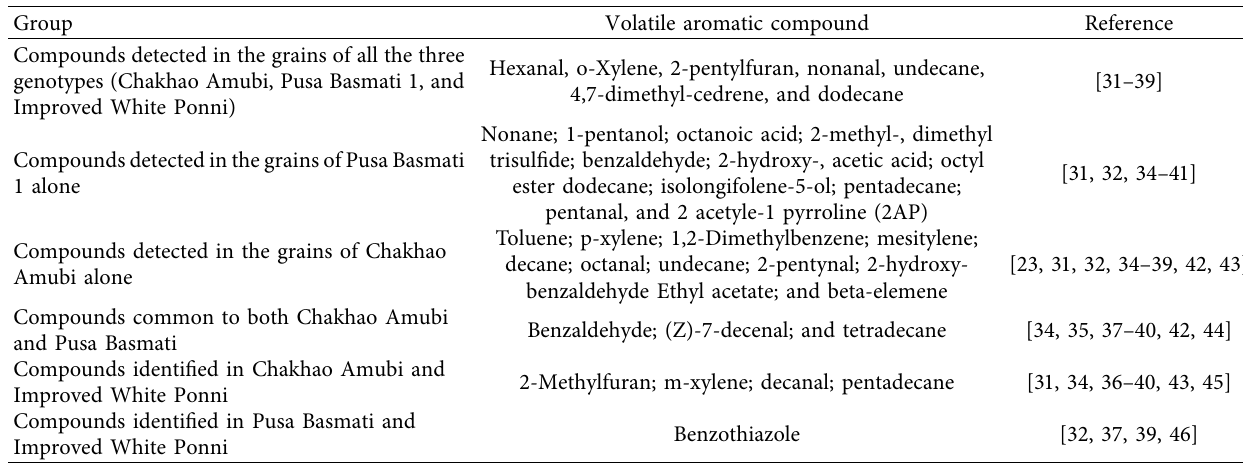
Table 1: List of volatile compounds identified in grains of Chakhao Amubi, Improved White Ponni, and Pusa Basmati 1 cultivars. Group Volatile aromatic compound Compounds detected in the grains of all the three genotypes (Chakhao Amubi, Pusa Basmati 1,